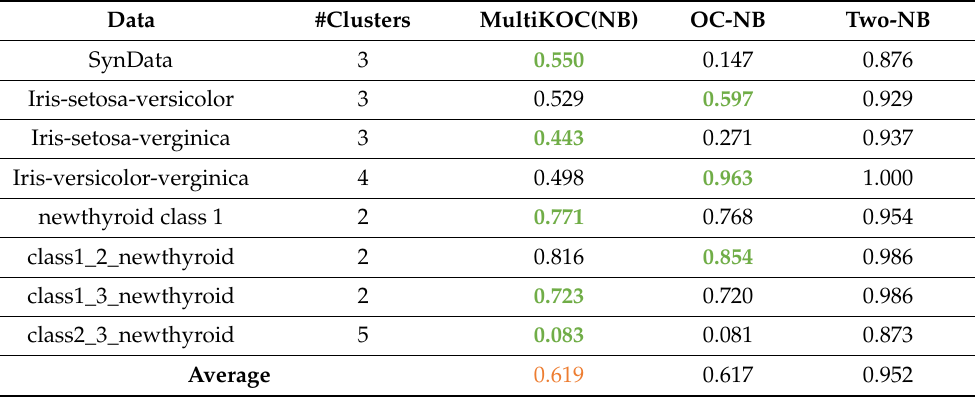
Table 3. Results summary for Naïve Bayes classifier. The column #clusters is the optimal number of clusters obtained for